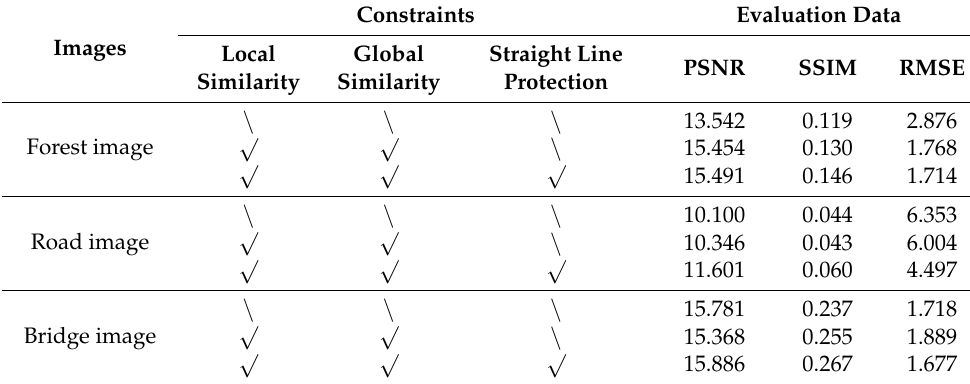
Table 1. Numerical Results of Ablation Experiment.